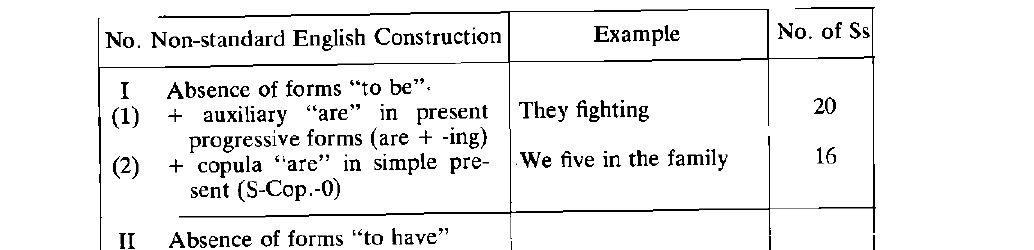
TABLE I: Non-Standard auxiliary/Copula verb forms in Coloured children No. Non-standard English